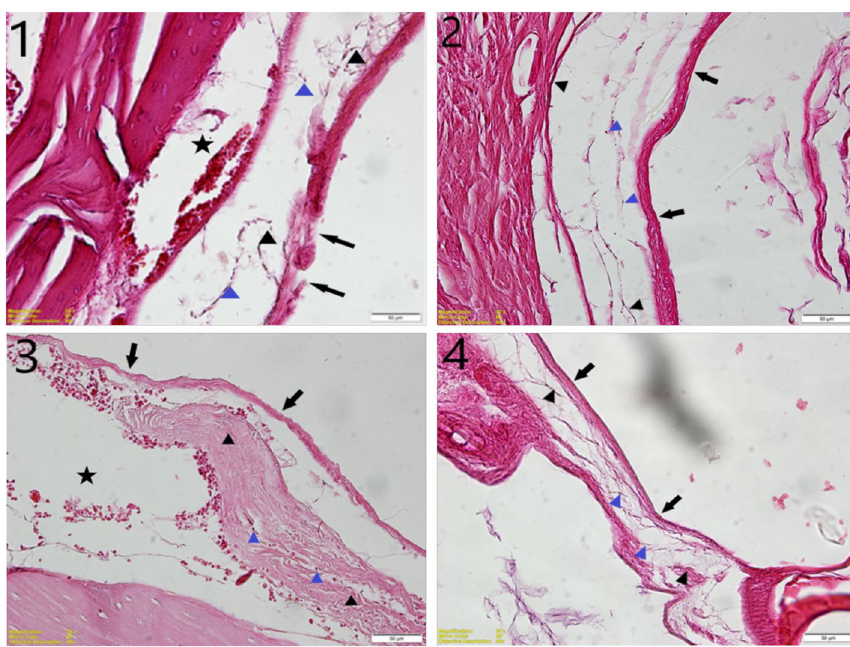
Fig. 2 On the 7th day after tympanic membrane perforation, group NC (1), group C (2), group TV (3), group HO (4) (H&E Staining, 20 magnification) epithelization (right arrow), inflammatory cells under the epithelium (star), fibroblast cells (blue triangle), and collagen fibers × (black